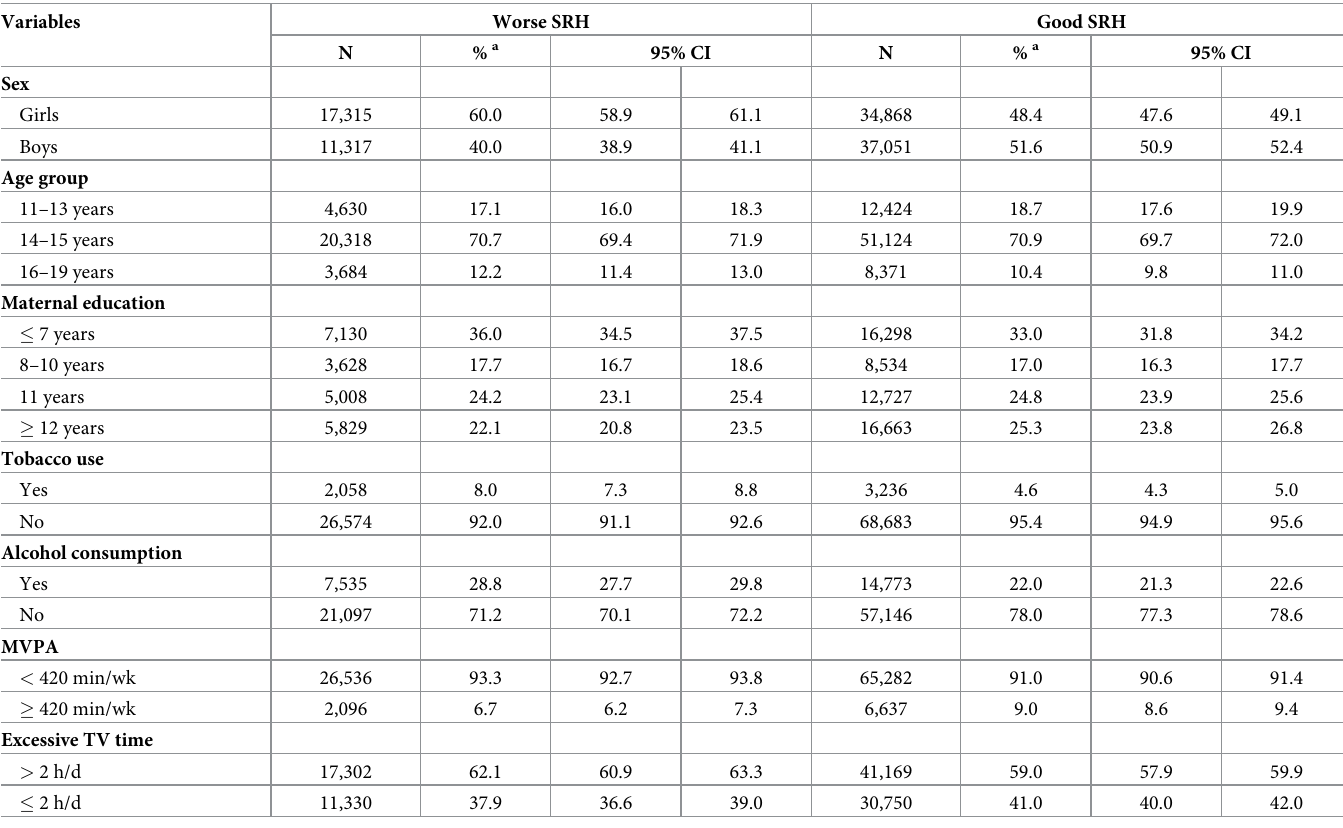
Table 1. Sociodemographic and Behavioural characteristics in Brazilian adolescents according self-rated health. National Adolescent School-based Health Survey (PeNSE). Brazil 2015 (n = 100,551).